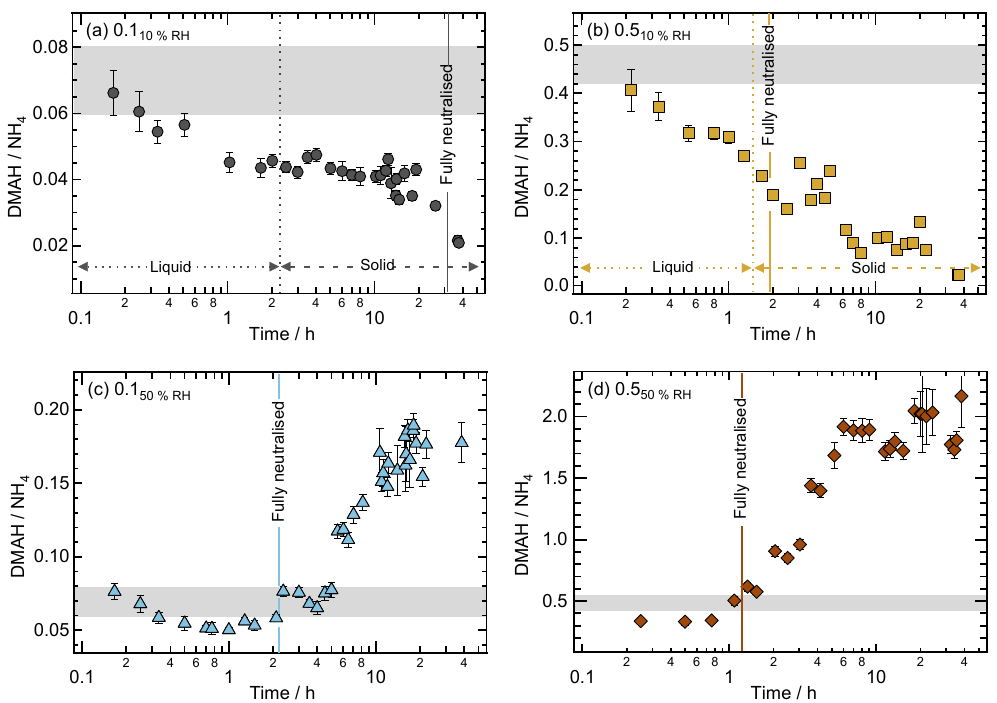
Figure 3. Particulate DMAH / NH 4 molar ratios as a function of time for DMA–NH 3 co-uptake at (a) DMA / NH 3 = 0 . 07 at 10% RH (0.1 10% ), (b) DMA / NH 3 = 0 . 46 at 10% RH (0.5 10% ), (c) DMA / NH 3 = 0 . 07 at 50% RH (0.1 50% ) and (d) DMA / NH 3 = 0 . 49 at 50% RH (0.5 50% ). DMA / NH 3 gas molar ratios (including uncertainties) are indicated by the grey bands. Dashed vertical lines indicate that the majority of particles underwent phase transition from liquid to solid. Solid vertical lines indicate that particles reached a neutralisation ratio of two. Uncertainties from ion chromatography analysis are displayed on the vertical axis unless they are smaller than the